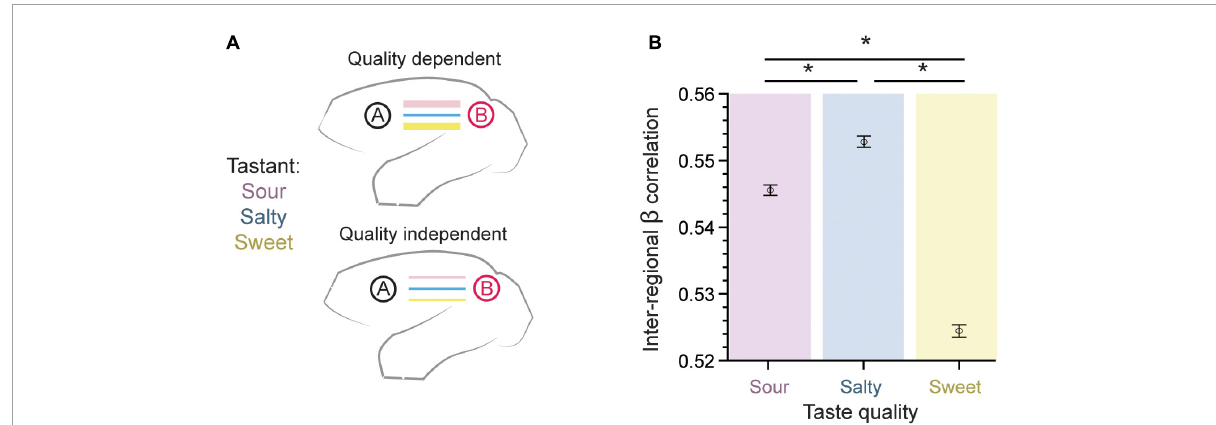
FIGURE3 Inter-regional pairwise correlations across taste type. (A) The connection strength between pairs of brain regions measured using the β -series could either be dependent on the taste quality presented (top) or taste quality independent (bottom). (B) The error bar plot of inter-regional β coefficient correlation (mean ± SEM) is largest for salty and sour taste presentations as compared to sweet ( p = 6.7 × 10 - 123 , one-way ANOVA, n = 456,228). This result supports a taste quality dependent model of connectivity within the gustatory connectome. *Indicates significant differences between pairs, with p < 10 − 8 . Tukey’s post hoc